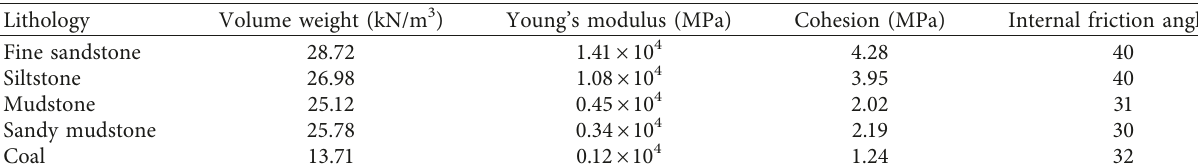
Figure 2: The lithology comprehensive strata diagram. Table 1: Mechanical parameters of rock mass.